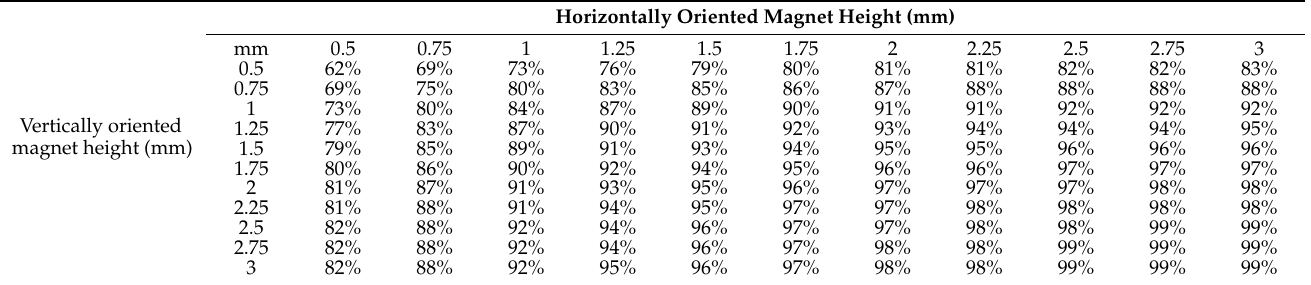
Table A2. Calculated recovery for different magnet heights showing that the addition of additional magnetic material has a decreasing impact as the magnet size increases. Additionally, it can be seen that there is no difference in the increase dependent on which magnet height is